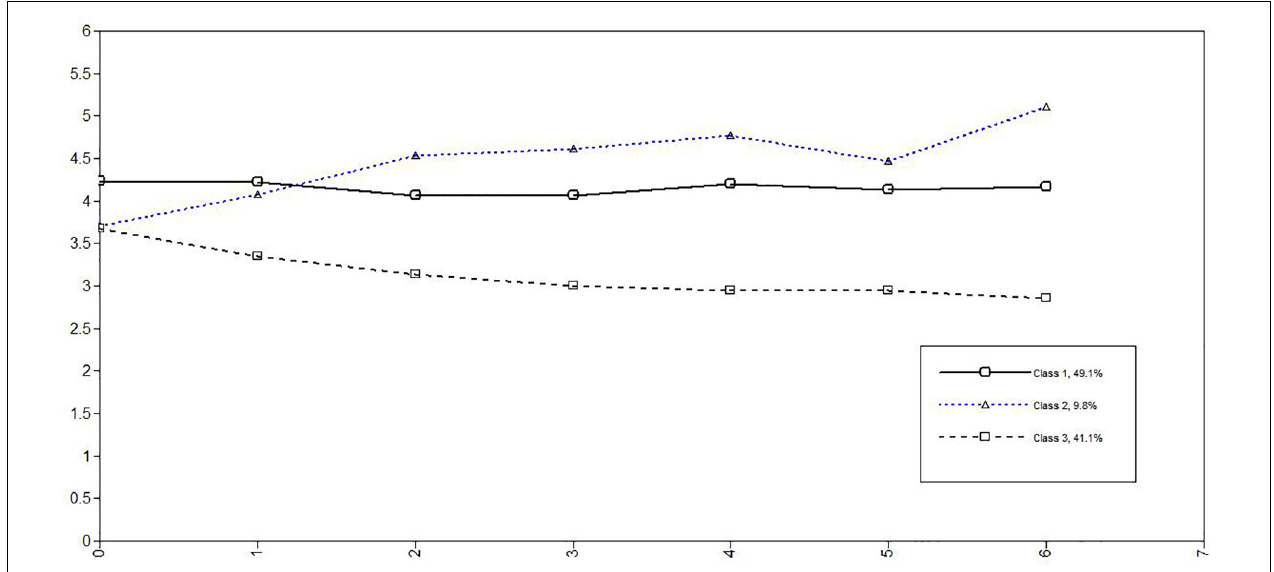
FIGURE 1 | The three trajectories of Positive Affect along the week, from Monday (0) to Sunday (6), identified by the conditional model (observed means).